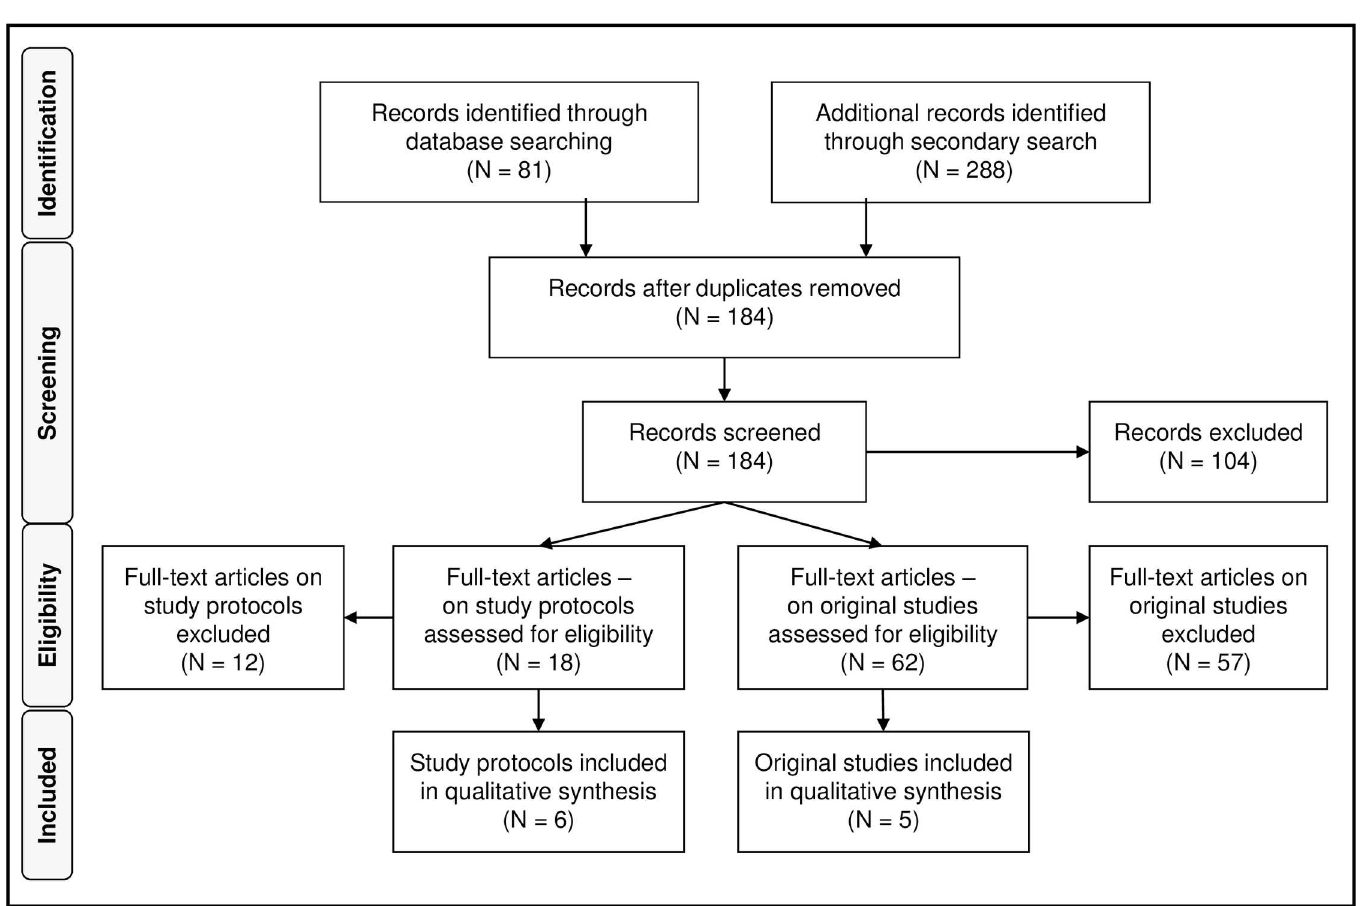
Fig 1. Flow diagram of study